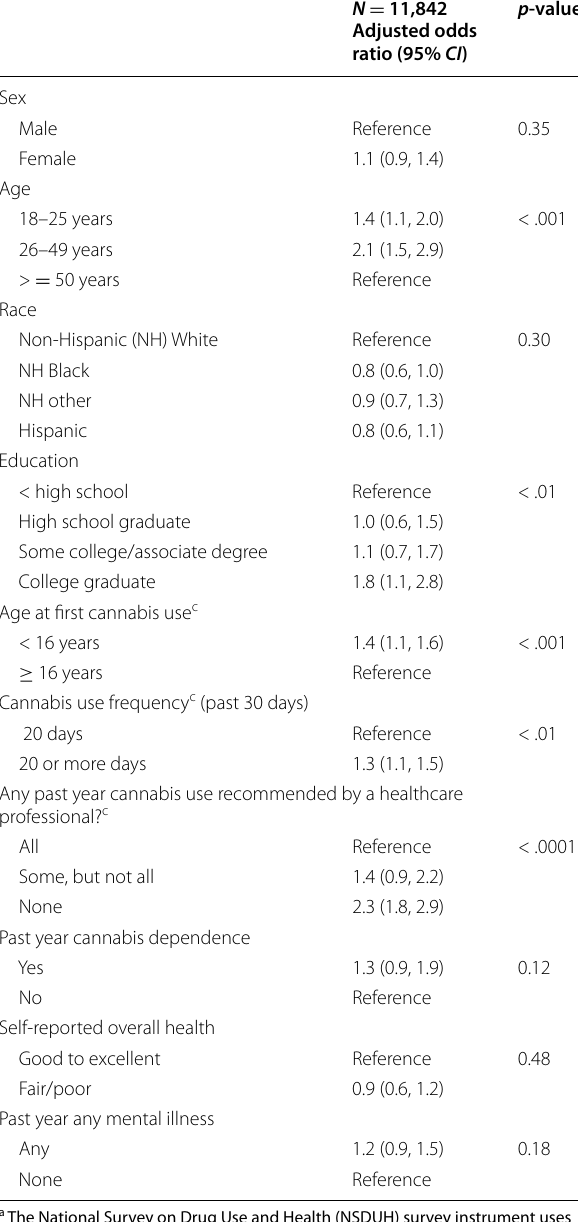
Table 3 Multivariable logistic regression assessing correlates of past 30-day cannabis a -only use (vs. cannabis and